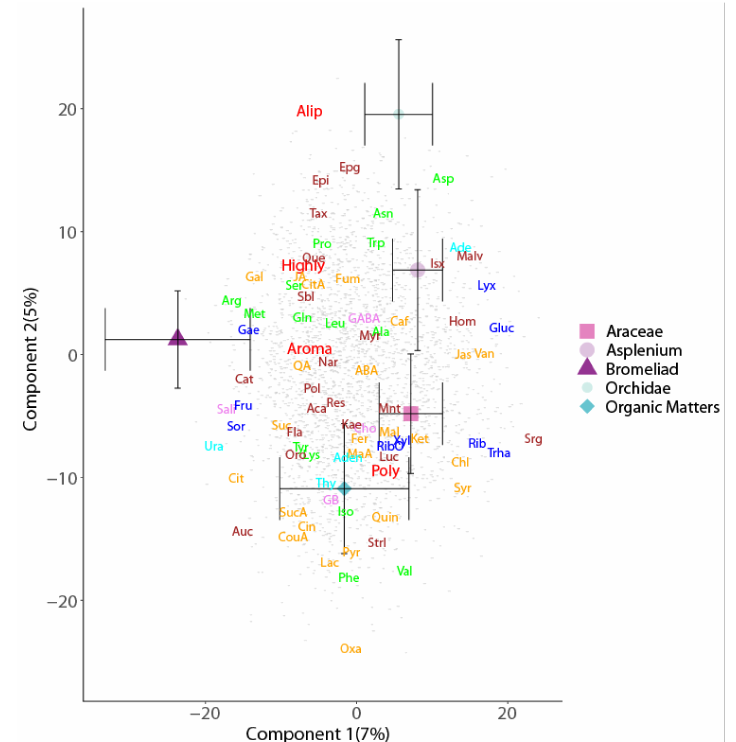
Figure 3. Partial least squares discriminant analysis biplots of metabolomic profiles of epiphyte (Araceae, Asplenium , Bromeliaceae, Orchidae)-associated and non-associated (organic matter) sus- pended soils. Depicted values are means ( ± 95% CI). Metabolites as in Figure